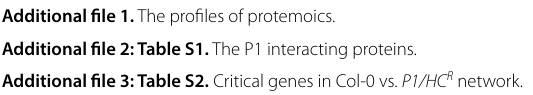
Additional file 2: Table S1. The P1 interacting